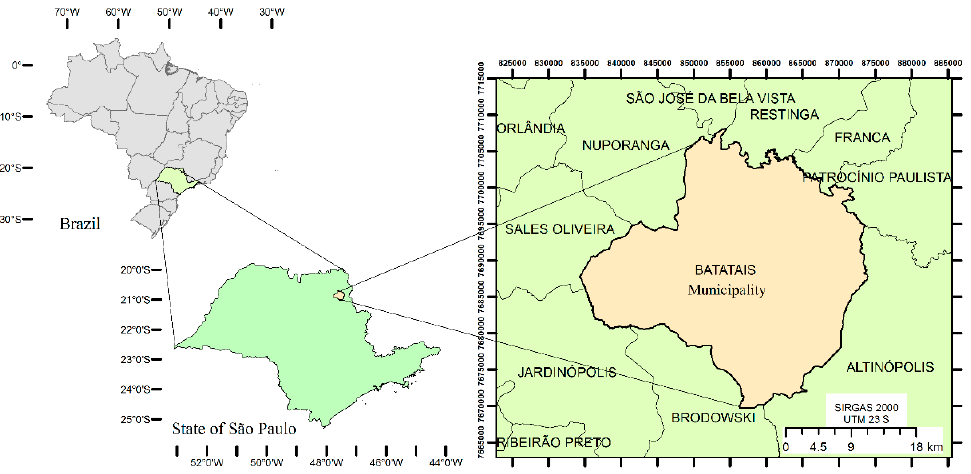
Figure 1. Study area, municipality of Batatais, São Paulo State, Brazil.